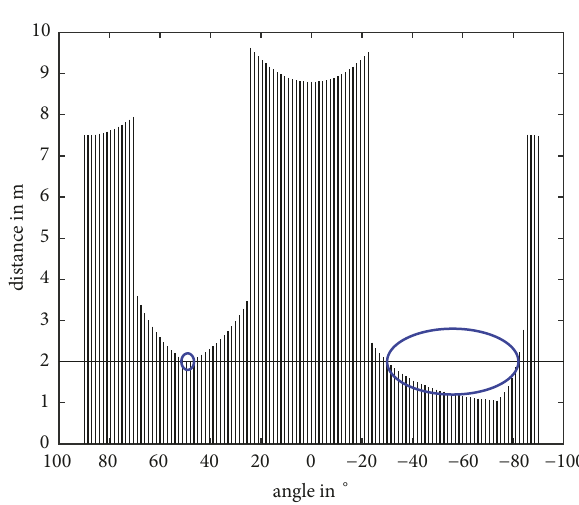
Figure 6: Sensor data and threshold